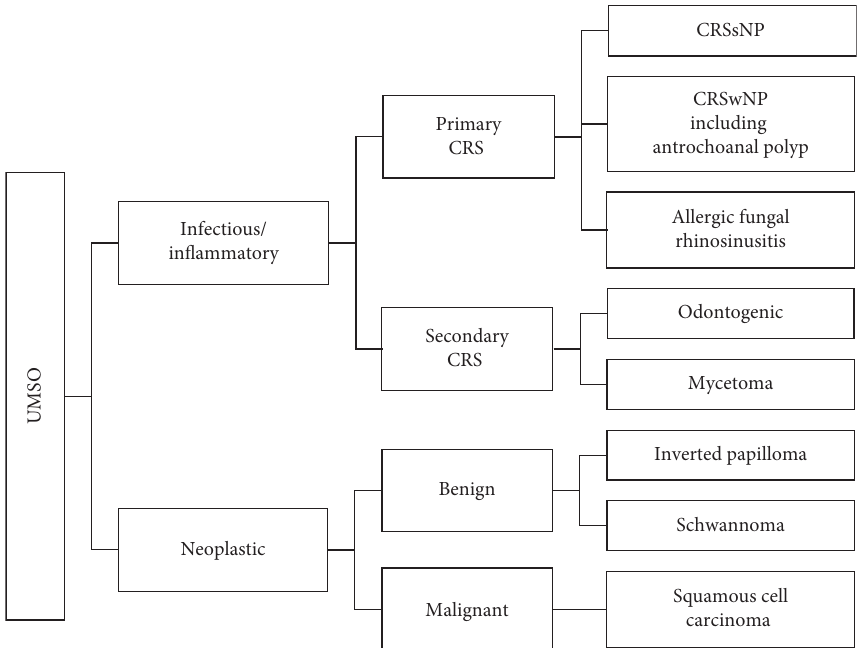
Figure 1: Causes of unilateral maxillary sinus opacification (UMSO). CRS: chronic rhinosinusitis, CRSsNP: CRS without nasal polyps, and CRSwNP: CRS with nasal